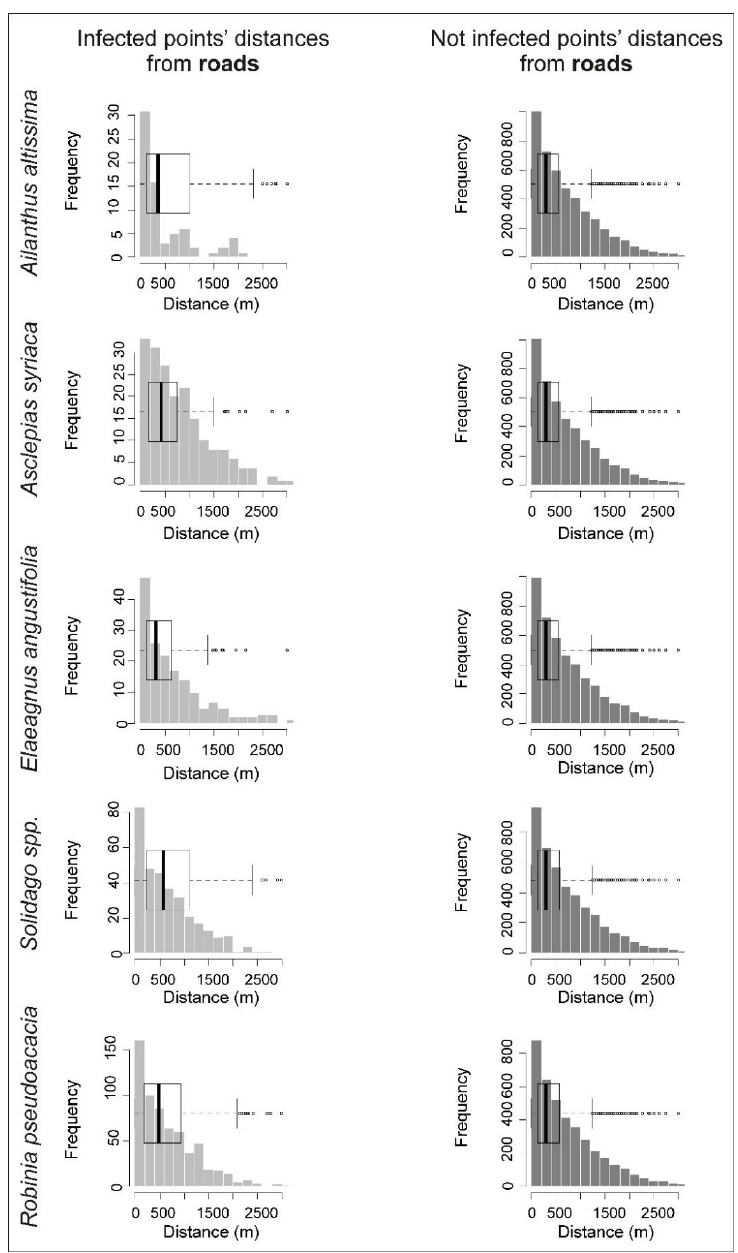
Figure A1. Histogram and boxplots of infected and not infected points’ distances from roads .